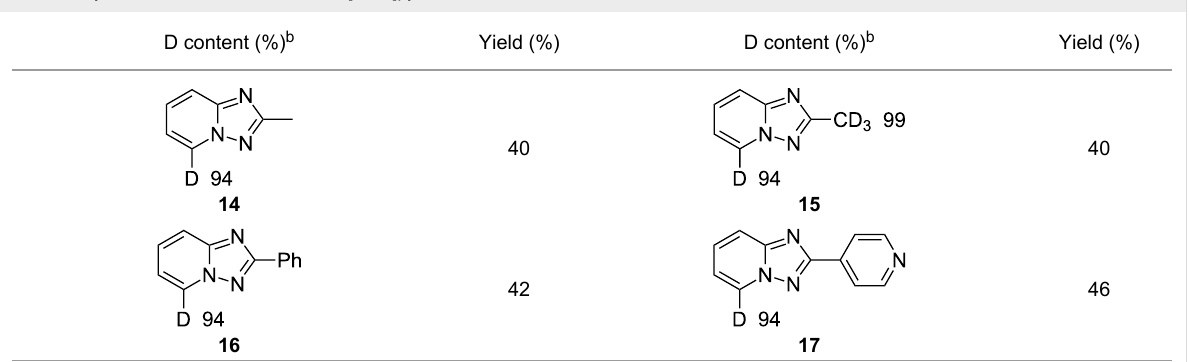
Table 2: Synthesis of deutero 1,2,4-triazolo[1,5- a ]pyridines a